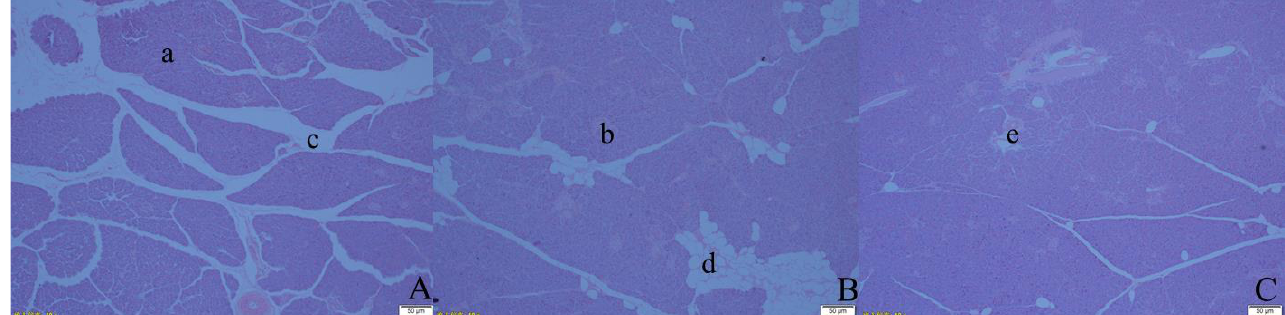
Figure 1. The pancreas morphological development in three different groups of yak calves: ( A ) the OP group of yak calves at 10×; ( B ) the AP group of yak calves at 10×; ( C ) the AOP group of yak calves at 10×. As seen in the images, the letters “a”, “b”, “c”, “d”, and “e” stand for glandular vesicles, pancreatic islets, interstitial spaces, fat vacuoles, and capillaries, respectively.